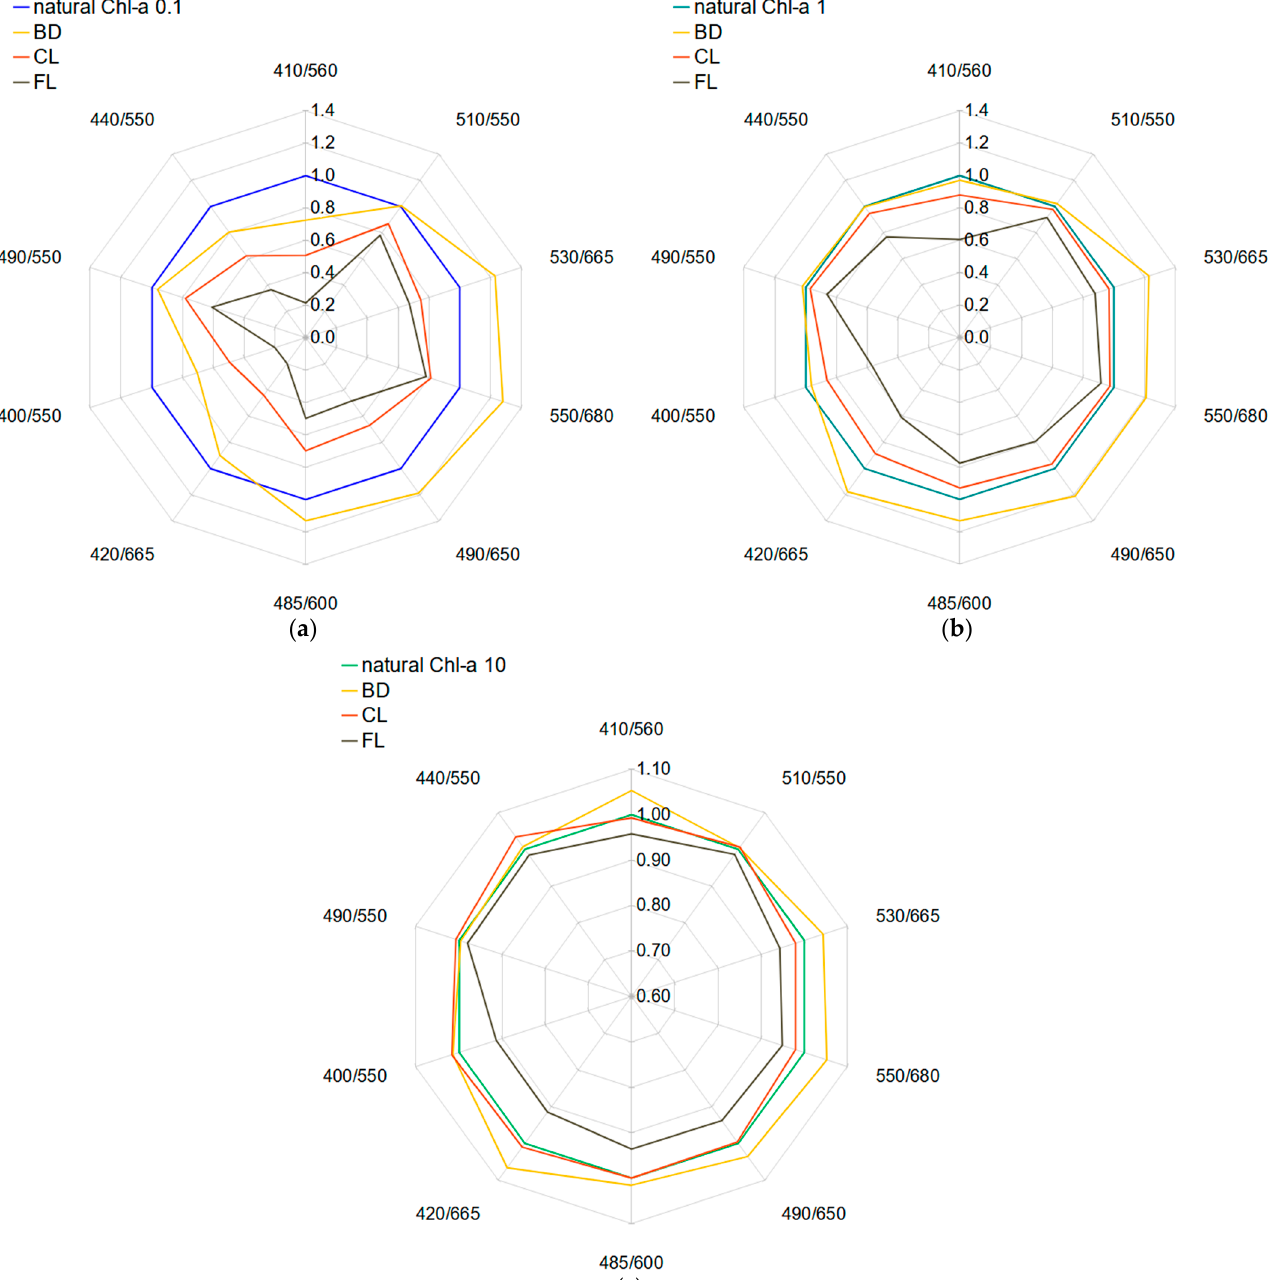
Figure 8. R rs band ratios for polluted water; fold change in relation to unpolluted natural water for ( a ) oligotrophic ocean water characterized by Chl-a = 0.1 mg/m 3 , ( b ) mesotrophic ocean water characterized by Chl-a = 1 mg/m 3 and ( c ) eutrophic ocean water characterized by Chl-a = 10 mg/m 3 .